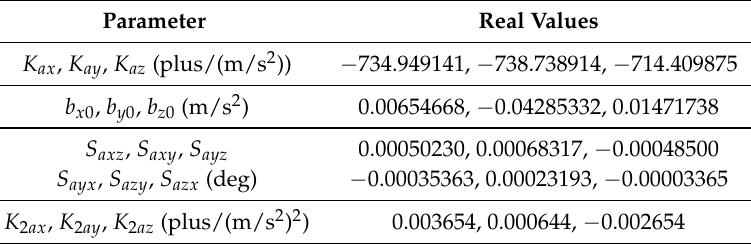
Table 1. Real value setting of calibration parameter.